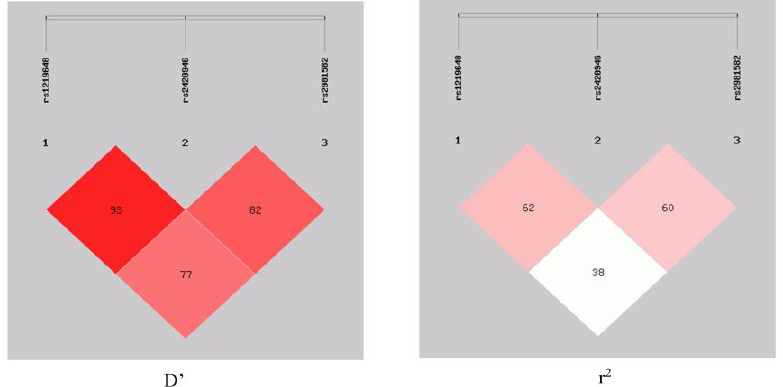
Figure 1. LD block between rs1219648, rs2420946, and rs2981582 in the case–control respondents.